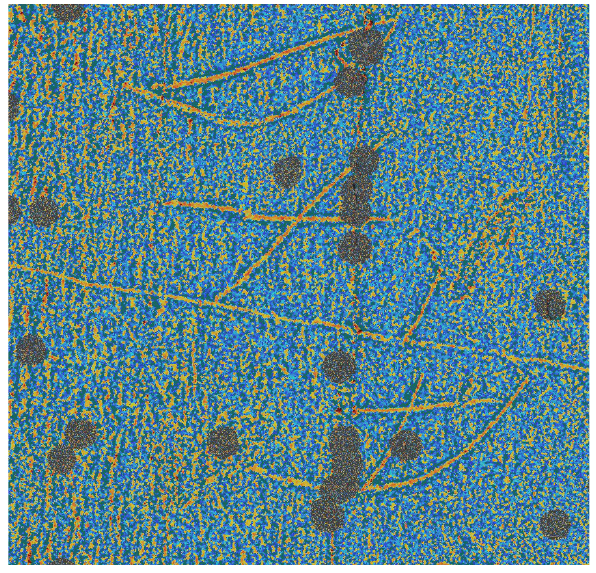
Figure 5. Deviations between two